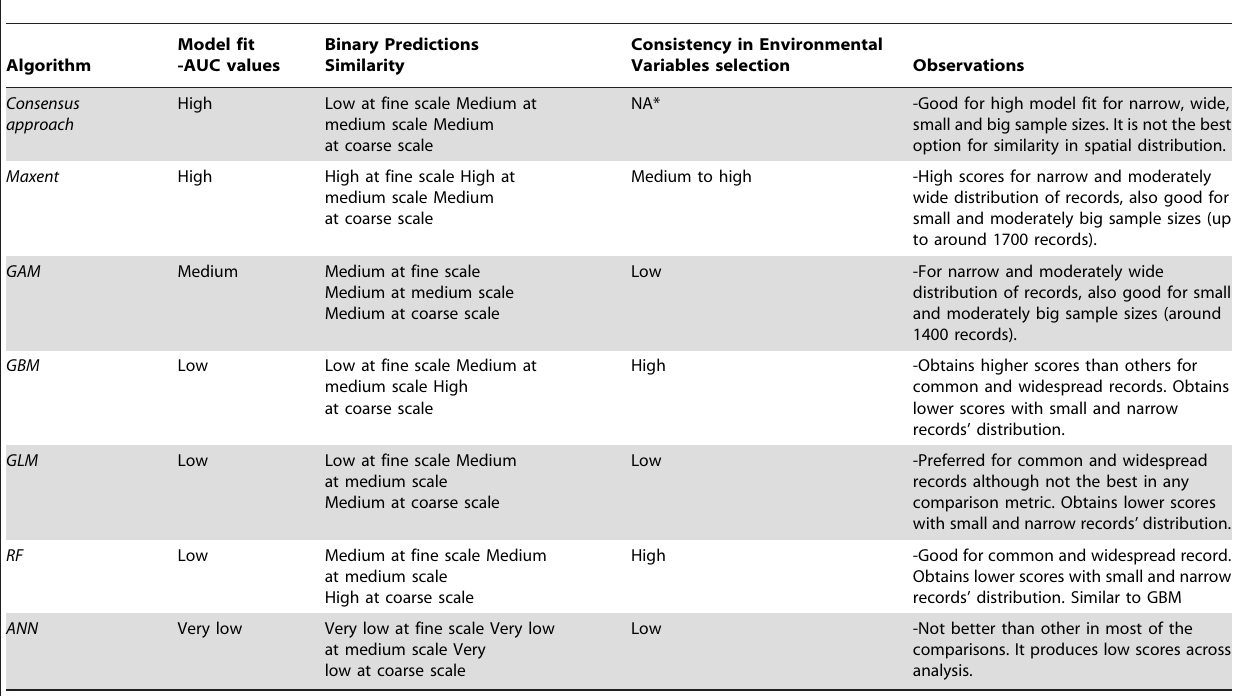
Table 2. Summary of the algorithms’ performance across analyses and the different aims for which they attain better results (for more details see Figs. 1, 2, 3).